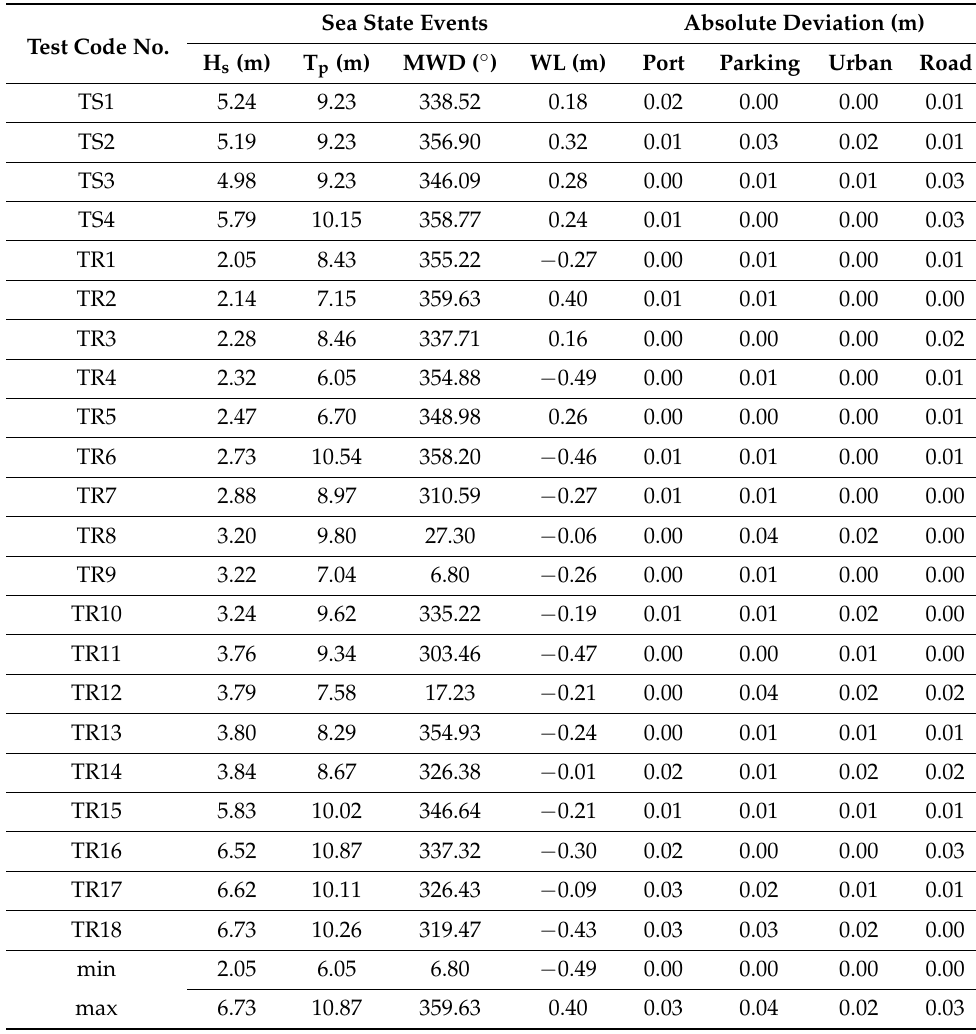
Table 3. Test dataset consisting of randomly selected sea-state events and absolute deviation of ANN predictions from